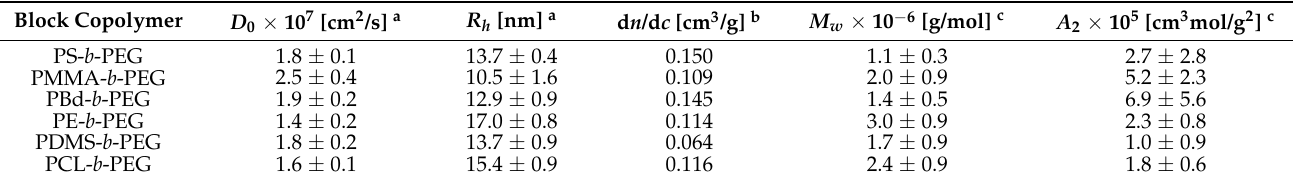
Table 4. Hydrodynamic parameters of block copolymers micelles in water at 25 ◦ C obtained by DLS and